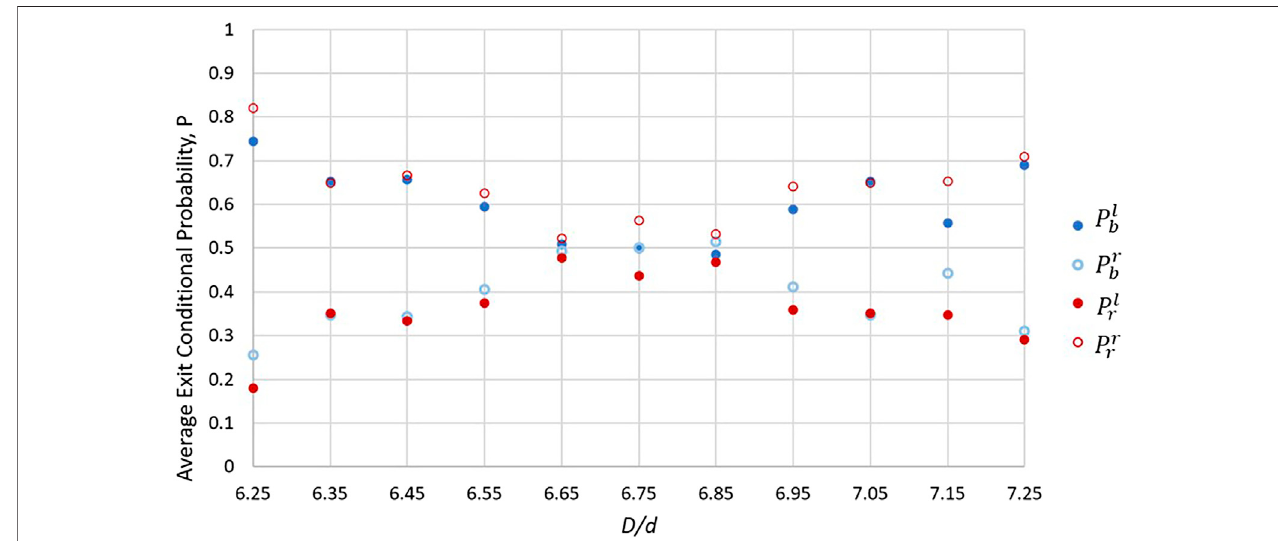
FIGURE 11 | Average of the exit conditional probability for D/d from 6.25 to 7.25 in chamber C6 of 2D ExtendedNUB model for Re (cid:1)